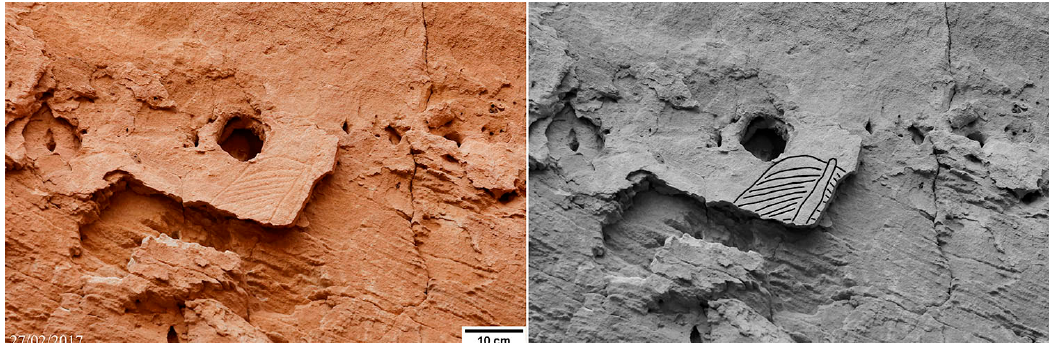
Figure 18. A fragment of an oval engraving (E5) with a longitudinal element tapering in a rounded termination (black and white version: interpretation by tracing, Photo: Alessandro Menardi Noguera).